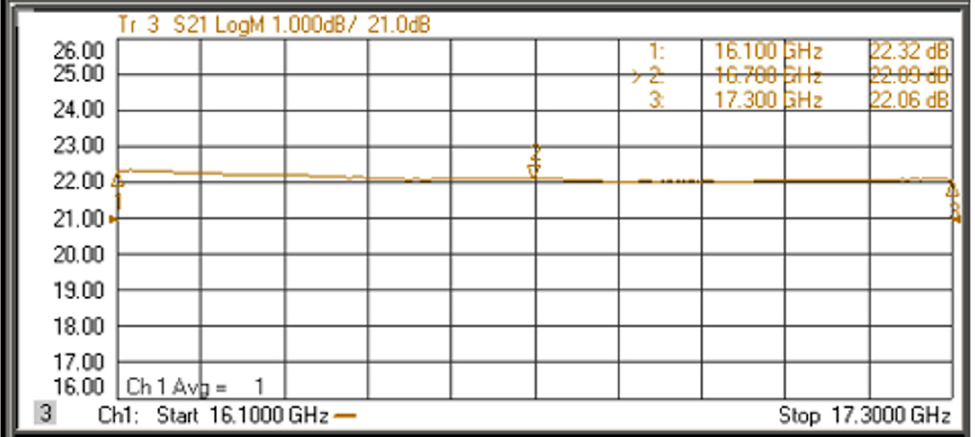
Figure 10. Measured results of receive.